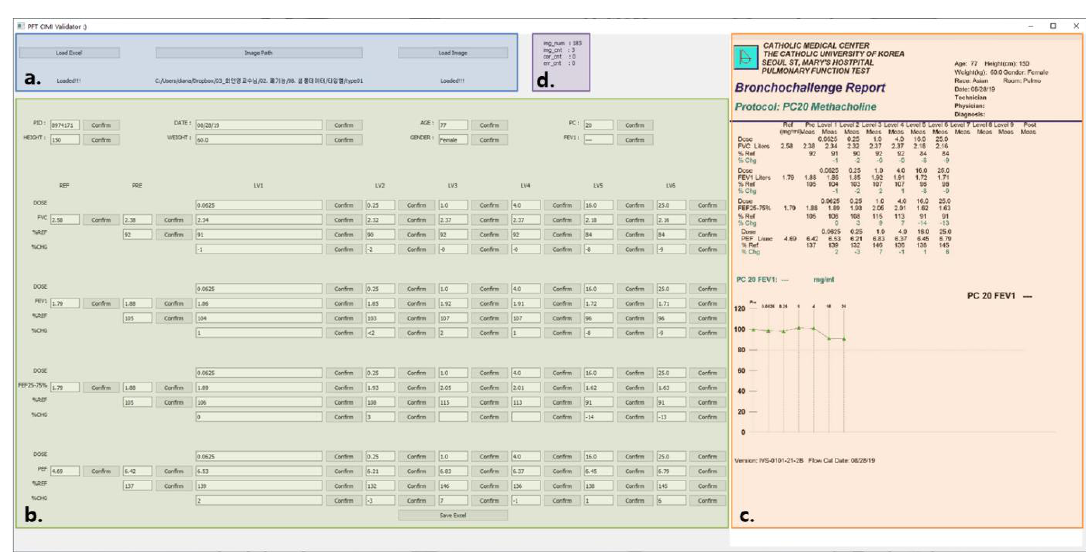
Figure 6. UX/UI screen of CIMI validation tool; ( a ) set the excel and the image file to validate; ( b ) the results from the excel; ( c ) the results of the image; ( d ) validation count information.